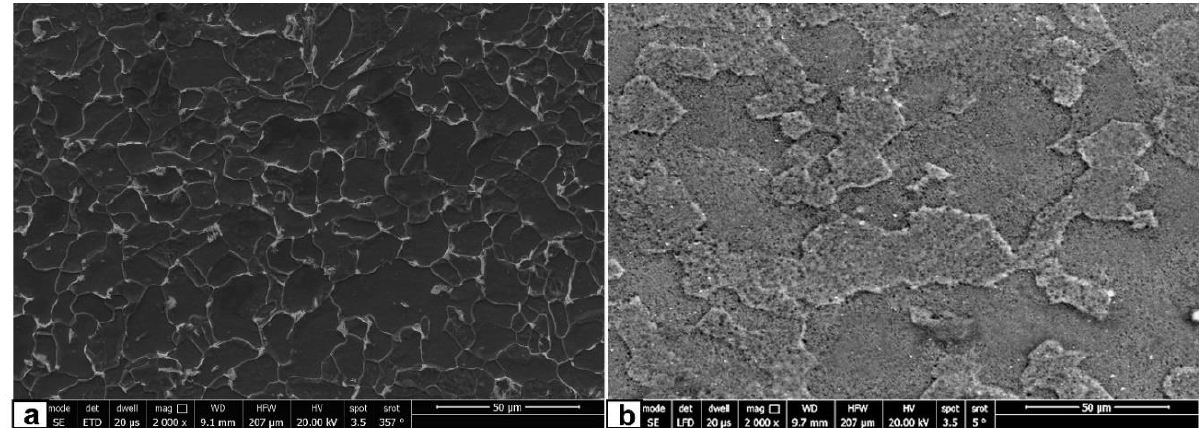
Figure 2. Micrographs of the low-carbon steel ( a ) and pure aluminum base metals ( b ).